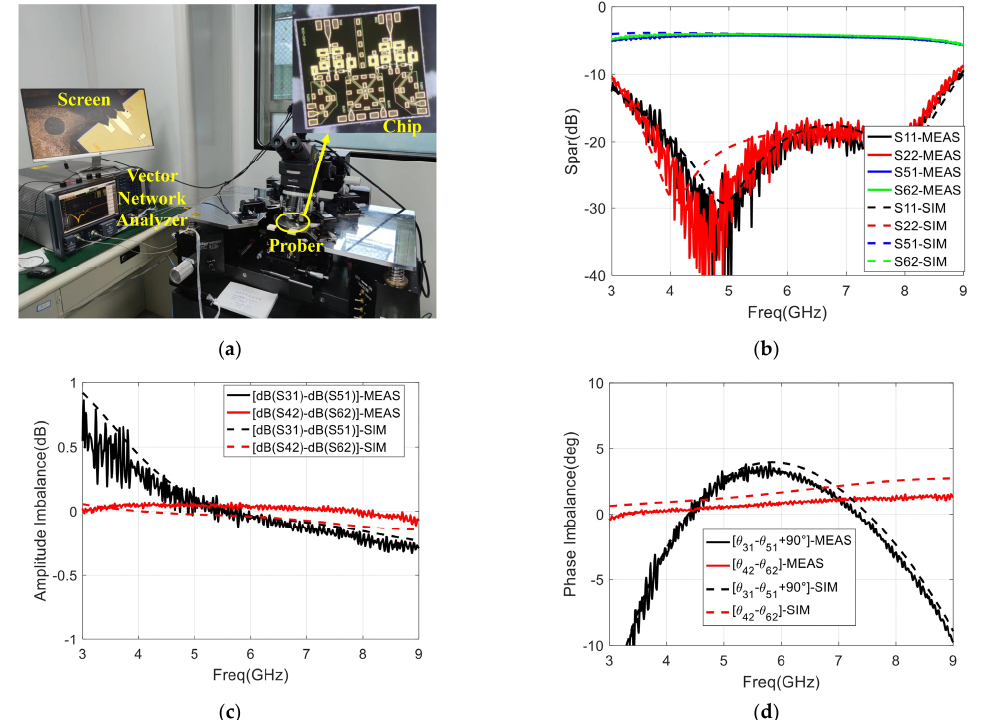
Figure 5. The test site and the measurement result of the designed chip: ( a ) The fabricated chip and measurement site; ( b ) Return loss of input port and insertion loss of the divider; ( c ) The amplitude imbalance of the divider; ( d ) The phase imbalance of the divider.